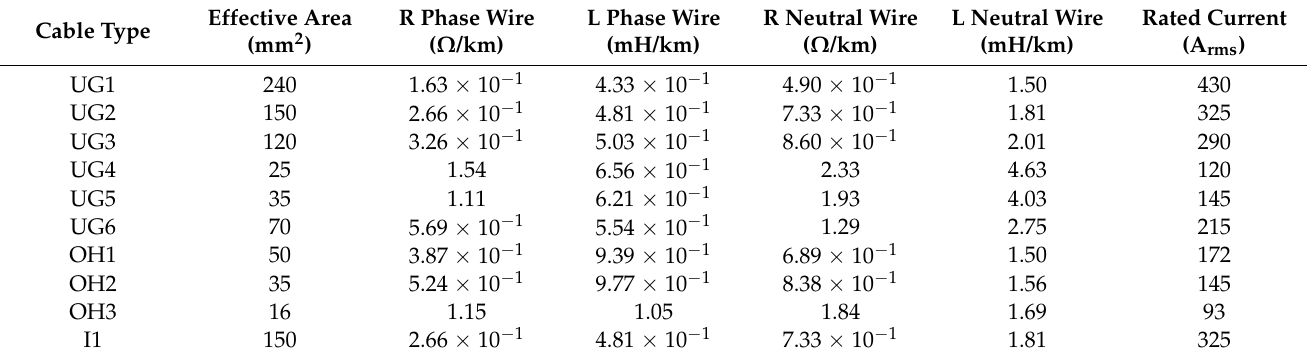
Table A1. Parameters of the cables used in the application example in Figure 1.